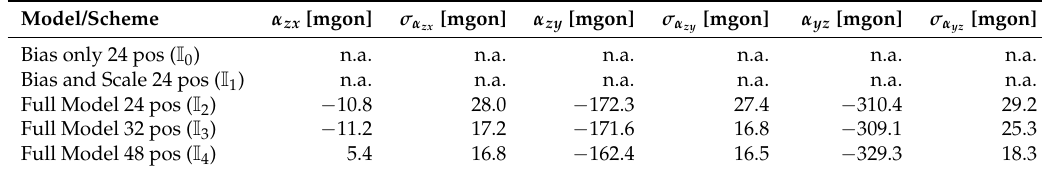
Table 4. Estimated non-orthogonality parameters of IMU calibration.